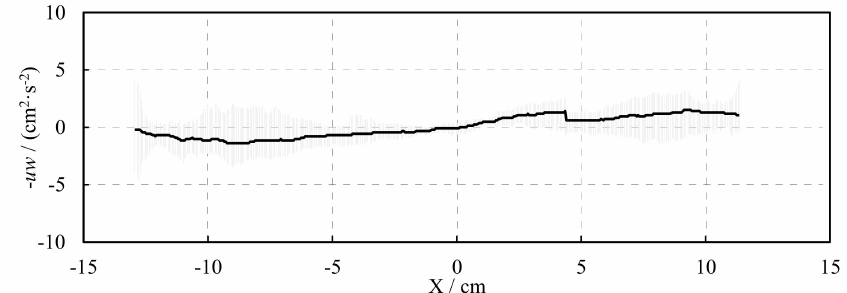
Figure 9. The spatial distribution of Reynolds stress and the variations when s = 0.5 cm and f = 3